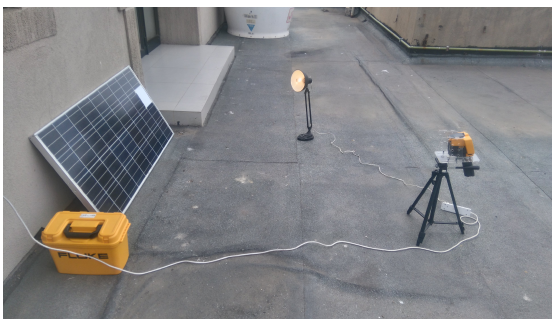
Figure 11. Proposed architecture to carry out the analysis and detection of false